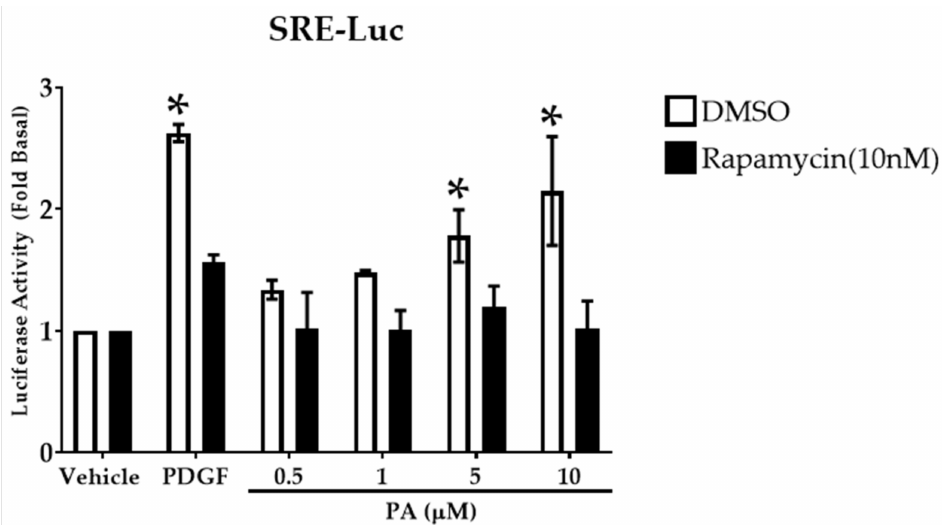
Figure 6. Effect of PA on transcription factor activation. Human ASM cells were transduced with lentivirus particles expressing luciferase under the control of multiple transcription factors and pre- treated with DMSO or rapamycin (10 nM) for 10 min followed by stimulation with PDGF (10 ng/mL) or PA (0.5 µ M–10 µ M) for 12 h. Luciferase activity was determined by measuring luminescence. Data are represented as fold-change to basal condition. Data above are mean ± SEM from n = 3–6 independent donors. * p < 0.05 compared to vehicle using one-way ANOVA with Bonferroni post-hoc analysis. PA treatment promoted SRE-Luc activity in human ASM cells among all the transcription factors tested. PA-induced SRE activation is mediated via mTOR